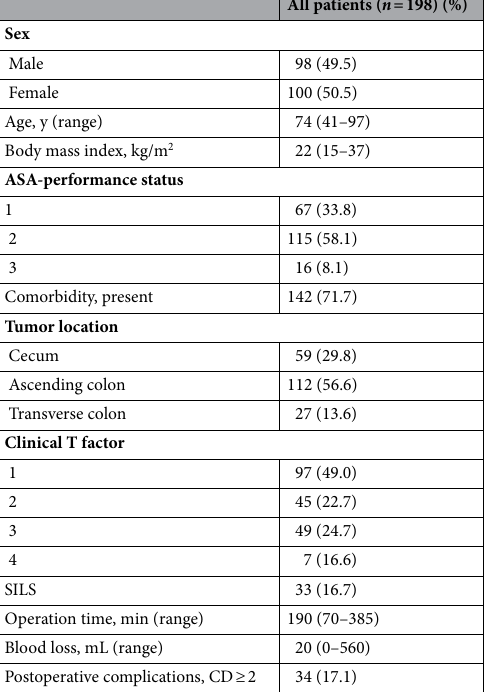
Table 1. Patients’ characteristics. Data are presented as numbers of patients or medians (range). ASA American Society of Anesthesiologists, SILS single-incision laparoscopic